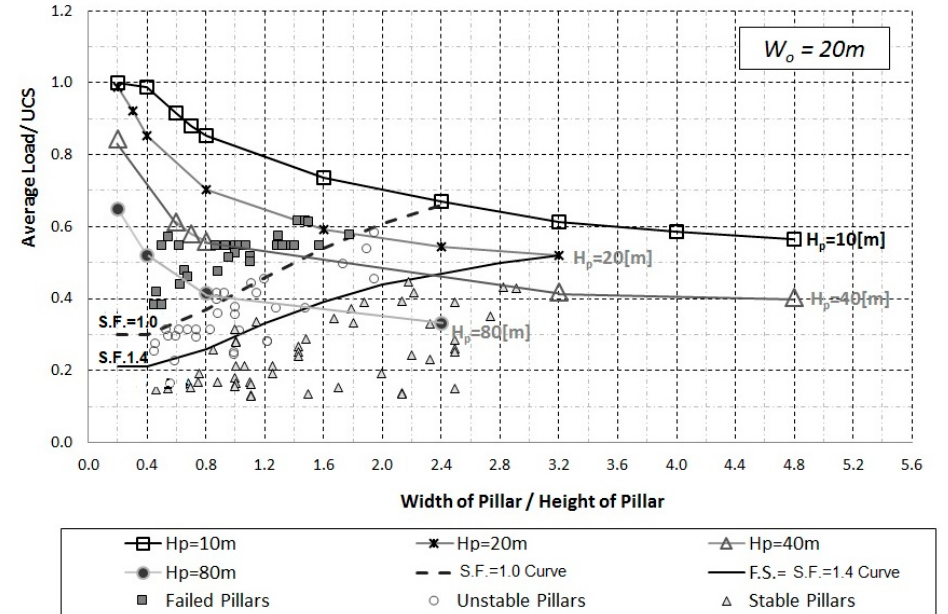
Figure 9. Empirical stability chart and modeling results—failure envelopes for different pillar heights H p .